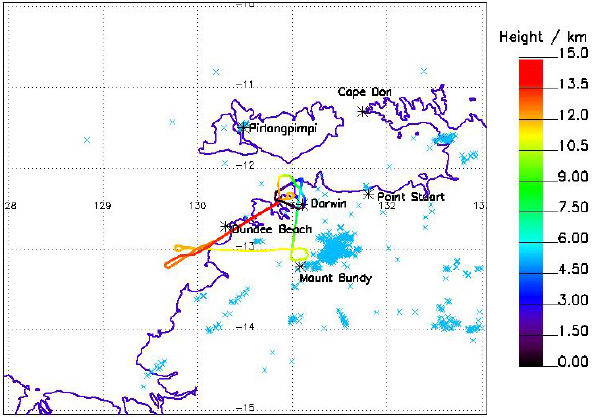
763 Figure 3. Egrett’s flight path on the 22 nd Jan. flight, colour­coded to altitude. The black 764 Fig. 3. Egrett’s flight path on the 22 Jan flight, colour-coded to al- asterisks mark the position of the six LINET stations deployed during ACTIVE and the 765 blue crosses are the LINET­detected strokes for the period 0:00­19:36 LT (i.e., from the 766 titude. The black asterisks mark the position of the six LINET sta- start of the day to the end of the flight). 767 tions deployed during ACTIVE and the blue crosses are the LINET- detected strokes for the period 00:00–19:36LT (i.e., from the start of the day to the end of the flight).